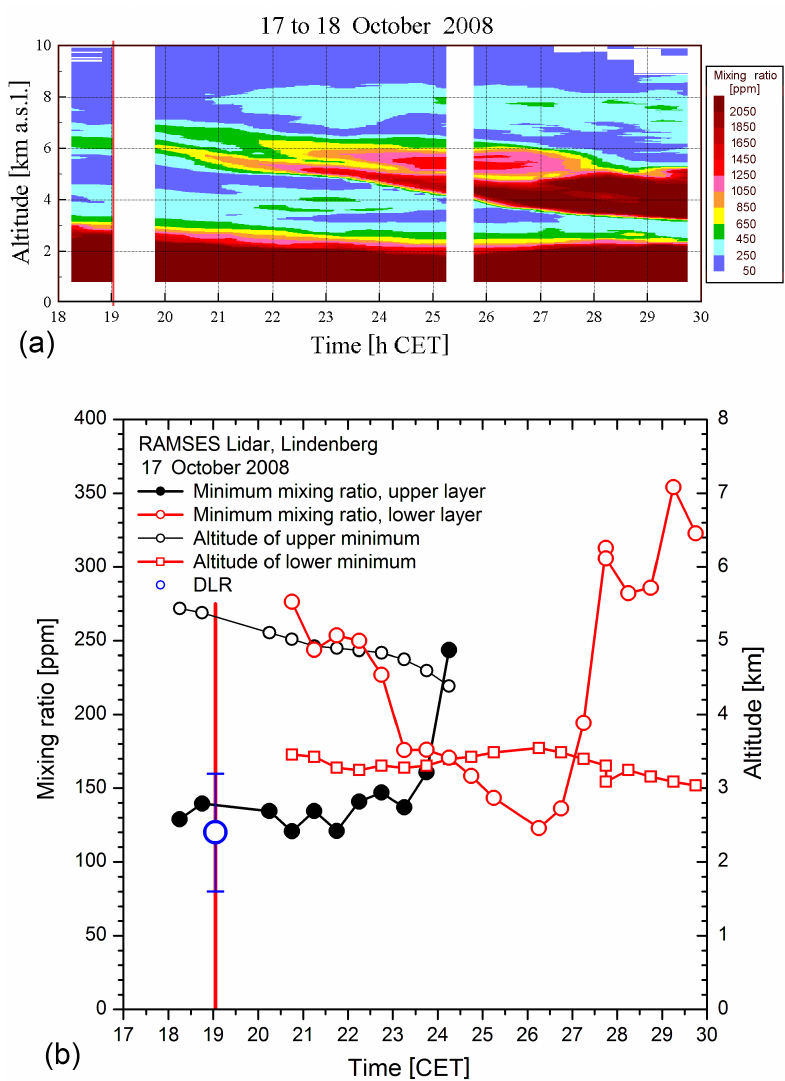
Figure 7. (a) Water-vapour time series of RAMSES on 17 October 2008 (Lindenberg); the time of the aircraft overflight (19:03CET) is marked by a red vertical line. (b) Time series of the two water-vapour minima in the stratospheric intrusion layer on 17 October 2008, as recorded by RAMSES, and the corresponding altitude; the time of the aircraft overflight (19:03CET) is marked by a red vertical line. The figure is based on 0.5h averages, the times being centred in the respective measurement